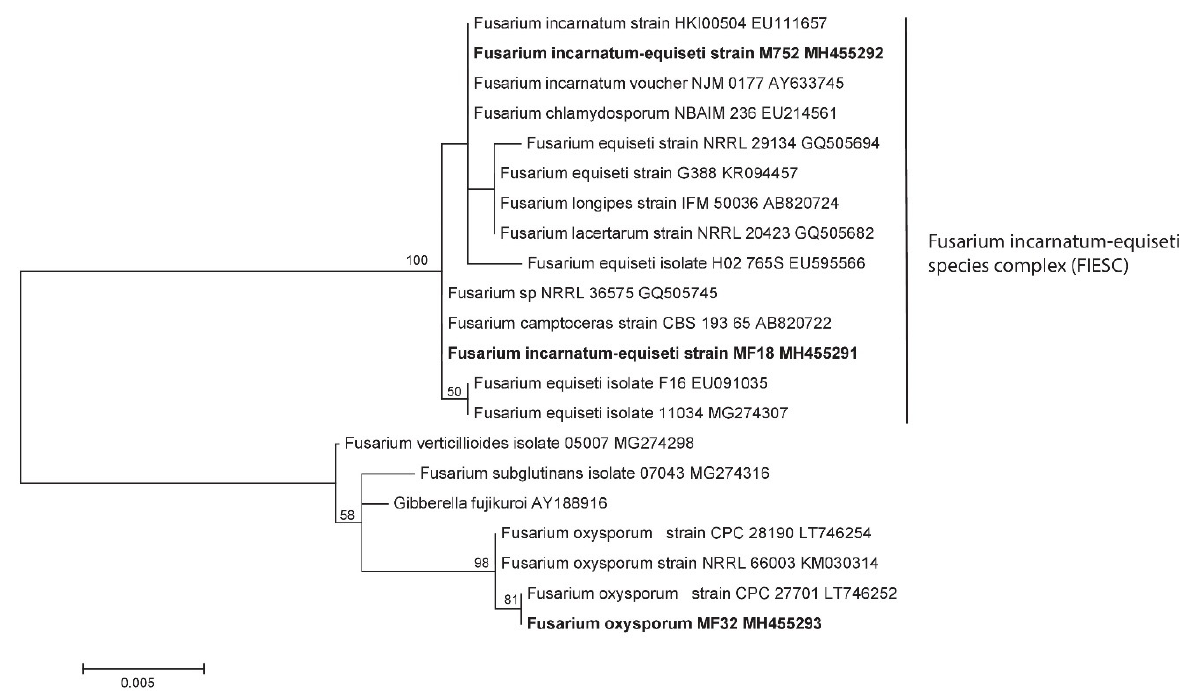
Figure 5. Genotypes belonging to species of the genus Fusarium obtained from samples. The mid-point rooting phylogenetic tree concatenated with maximum likelihood (1000 of bootstrap) for regions ITS-5.8S and partial LSU D1/D2 (Note: Bootstrap values above 50 are shown on the nodes).